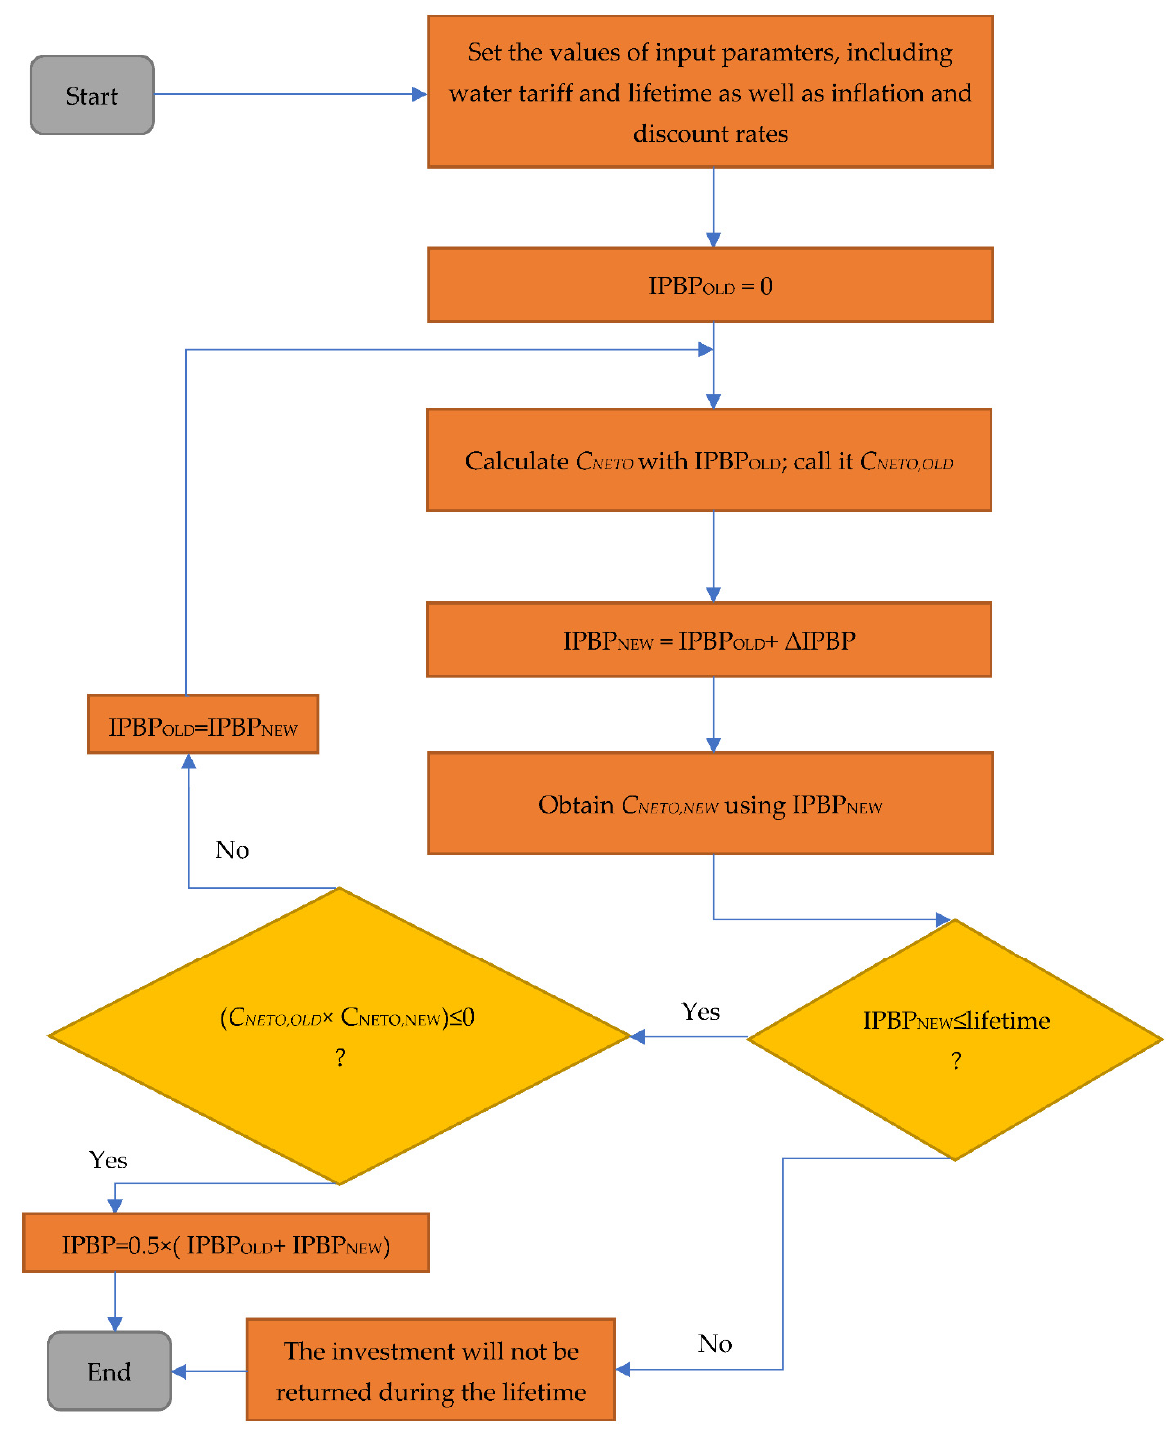
Figure A1. Flowchart of the way to determine IBPB from Equation (4).